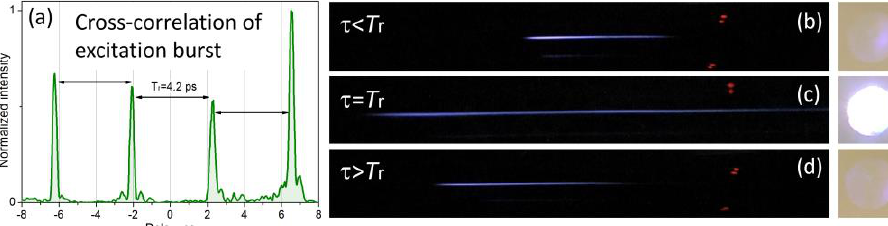
Fig. 2 . (a) Measured cross-correlation of a 4-pulse burst tuned to the rotational half-revivals of N 2 and programmed to have a high-intensity ionizing pulse following last after a sequence of aligning pulses. (b),(c),(d), Dependence of the N 2 plasma channel glow and output beam profile for the 4-pulse burst tuned on resonance (c) and detuned from resonance by ±200 fs.